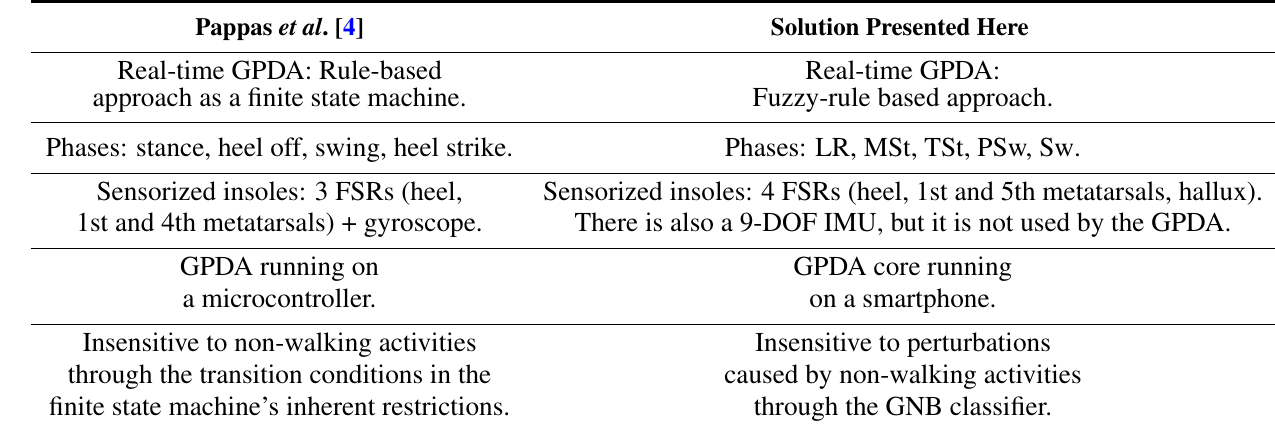
Table 2. Main similarities between the gait phase detection algorithm (GPDA) in Pappas et al. [4] and the solution presented in this paper. FSR, force-sensitive resistor; GNB, Gaussian naive